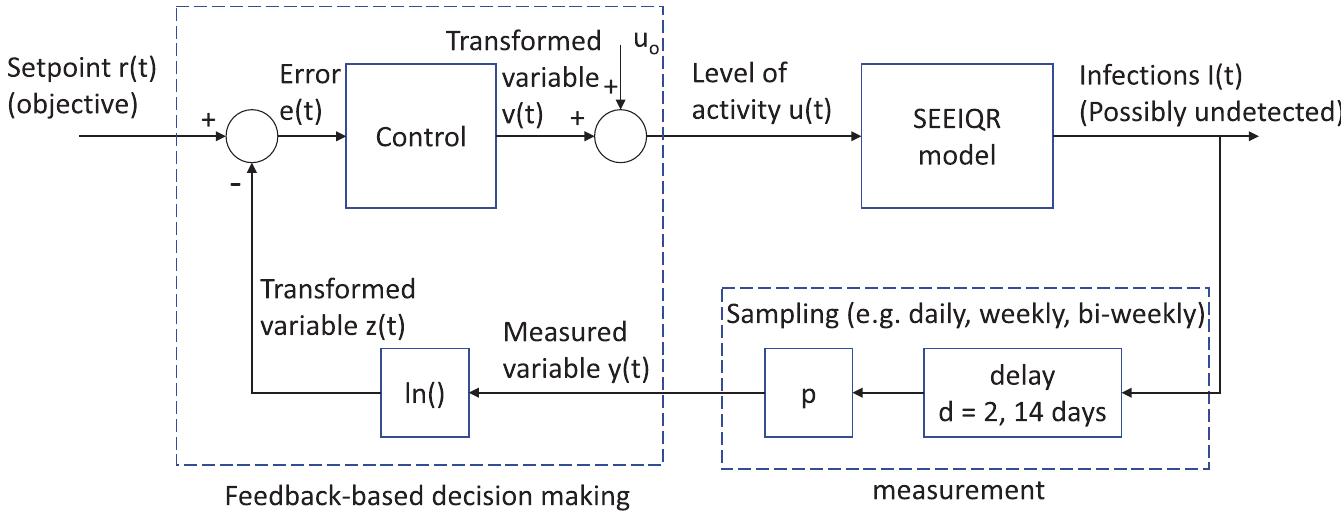
Fig 3. This block diagram illustrates the feedback configuration used in our simulations where the SEEIQR model (see S1 Appendix) is used to simulate the spread of COVID-19. The complete simulated feedback loop includes the SEEIQR model, measurements of case counts (1), the feedback control (6), and all transformations described in Section